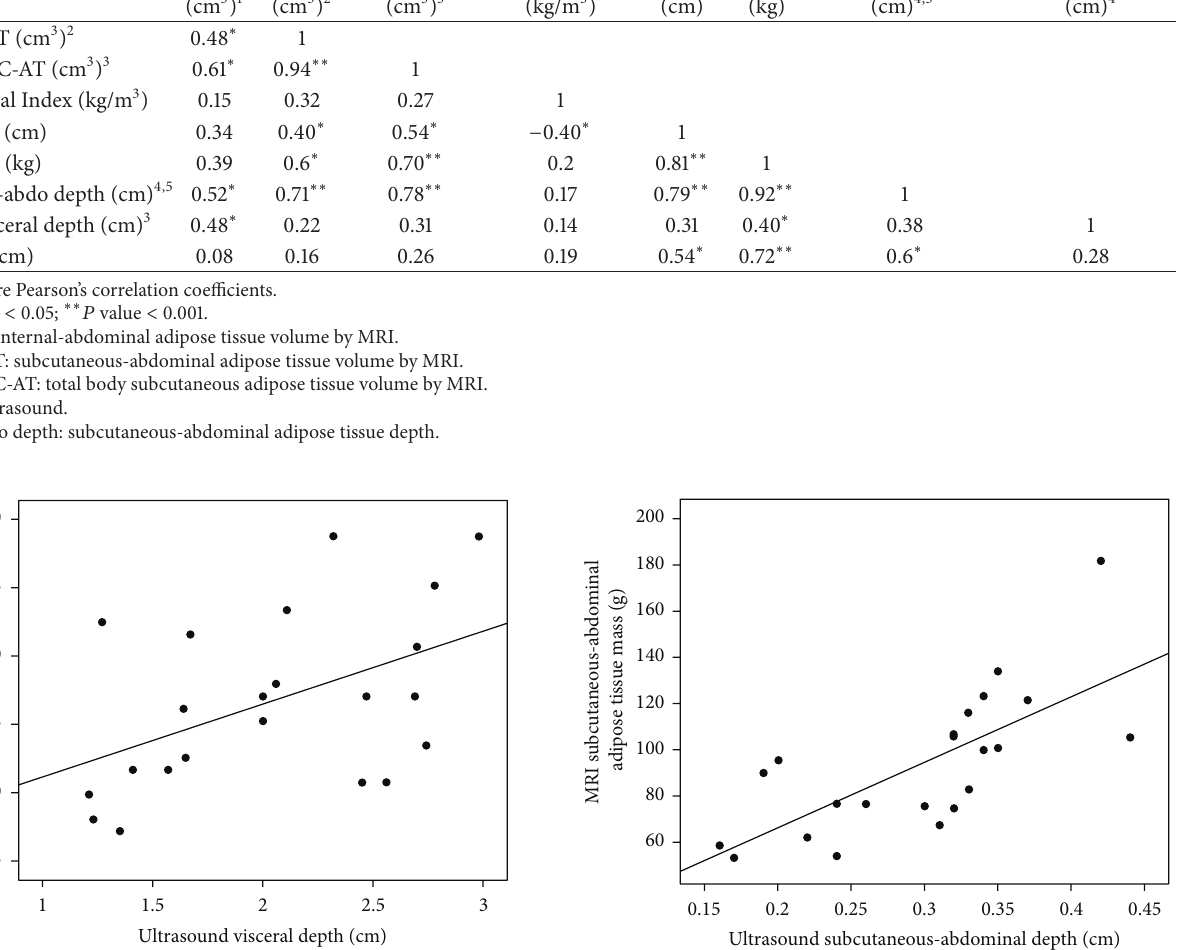
Table 2: Validation study: intercorrelations between MRI IA-AT or SCA-AT and anthropometry or ultrasound measures in 22 term infants. IA-AT SCA-AT Total SC-AT Ponderal Index Length Weight US-SC-abdo depth US-visceral depth